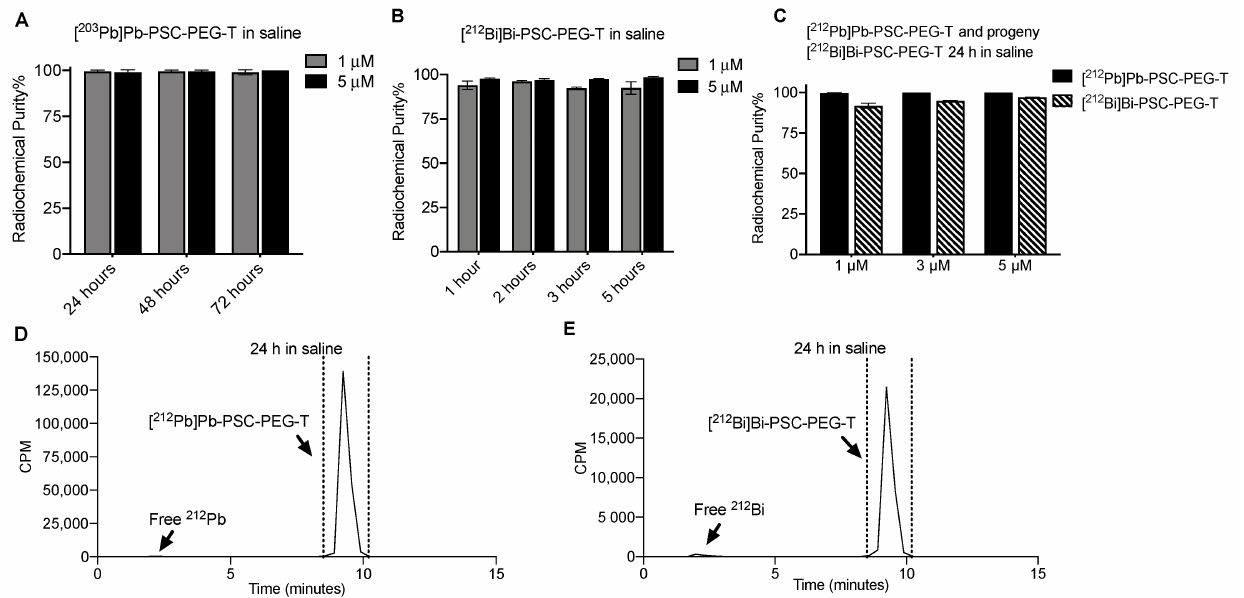
Figure 3. Stability of radiometal and radiopeptide in saline. Radiochemical stability of single species ( A ) [ 203 Pb]Pb-PSC-PEG-T and ( B ) [ 212 Bi]Bi-PSC-PEG-T with different concentrations of PSC-PEG-T precursor after storage in saline for 24 h (mean ± SD; n = 2); ( C ) Radiochemical stability of 212 Pb and progeny daughter 212 Bi in PSC-PEG-T (1, 3, 5 µ M) after 24 h in saline; Radio-HPLC analysis of ( D ) [ 212 Pb]Pb-PSC-PEG-T and ( E ) progeny [ 212 Bi]Bi-PSC-PEG-T after storage in saline for 24 h.